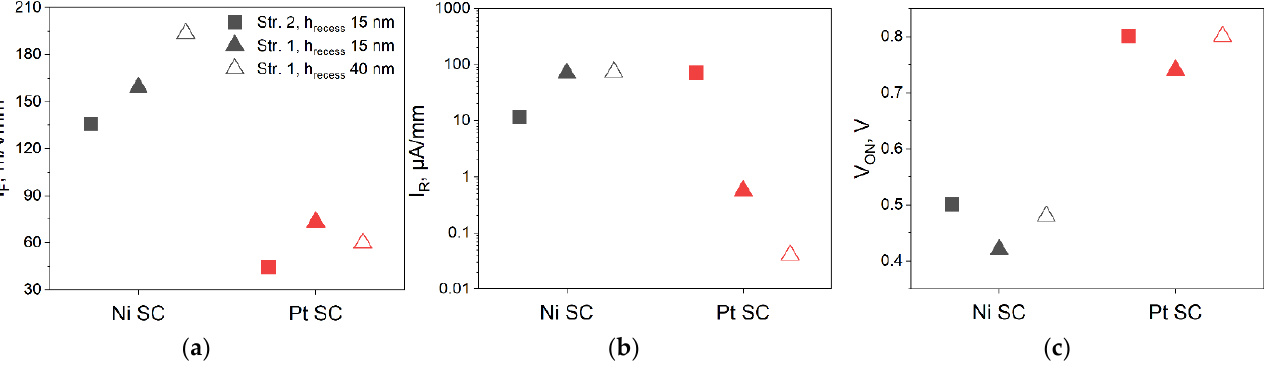
Figure 4. Comparison of electrical parameters of samples with different SC material: ( a ) Comparison Ni and Pt SCs’ I F ; ( b ) Comparison Ni and Pt SCs’ I R ; ( c ) Comparison Ni and Pt SCs’ V ON .